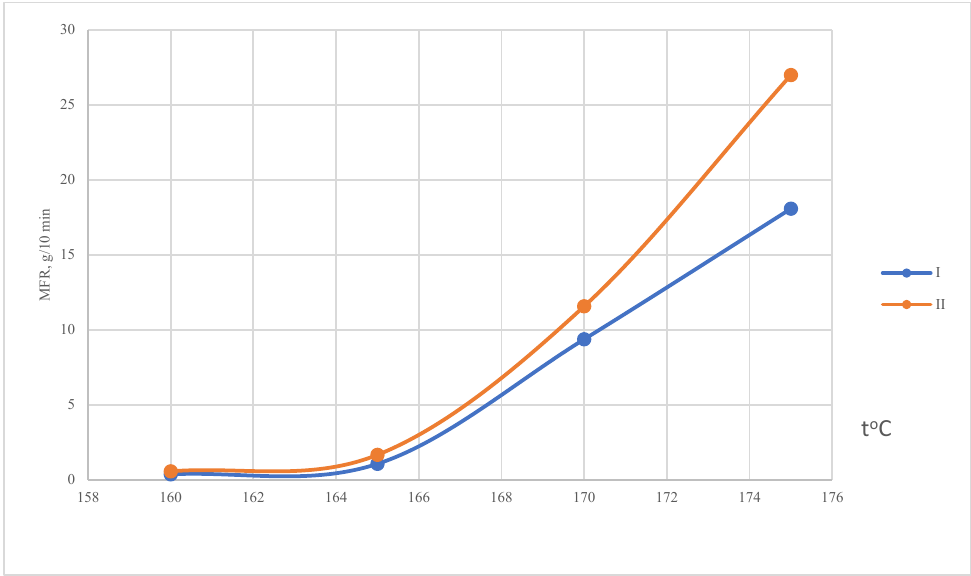
Figure 5. Dependence of the MFR of PVC composition on temperature . I, II—Symbols of plasticizers (Table 5).